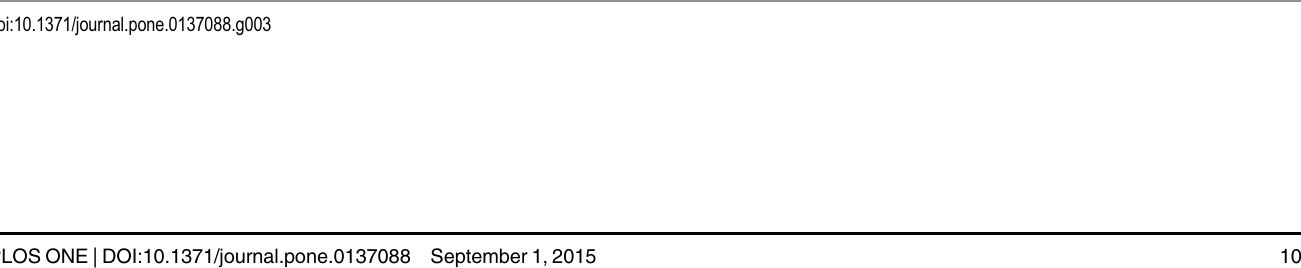
PLOS ONE | DOI:10.1371/journal.pone.0137088 September 1,